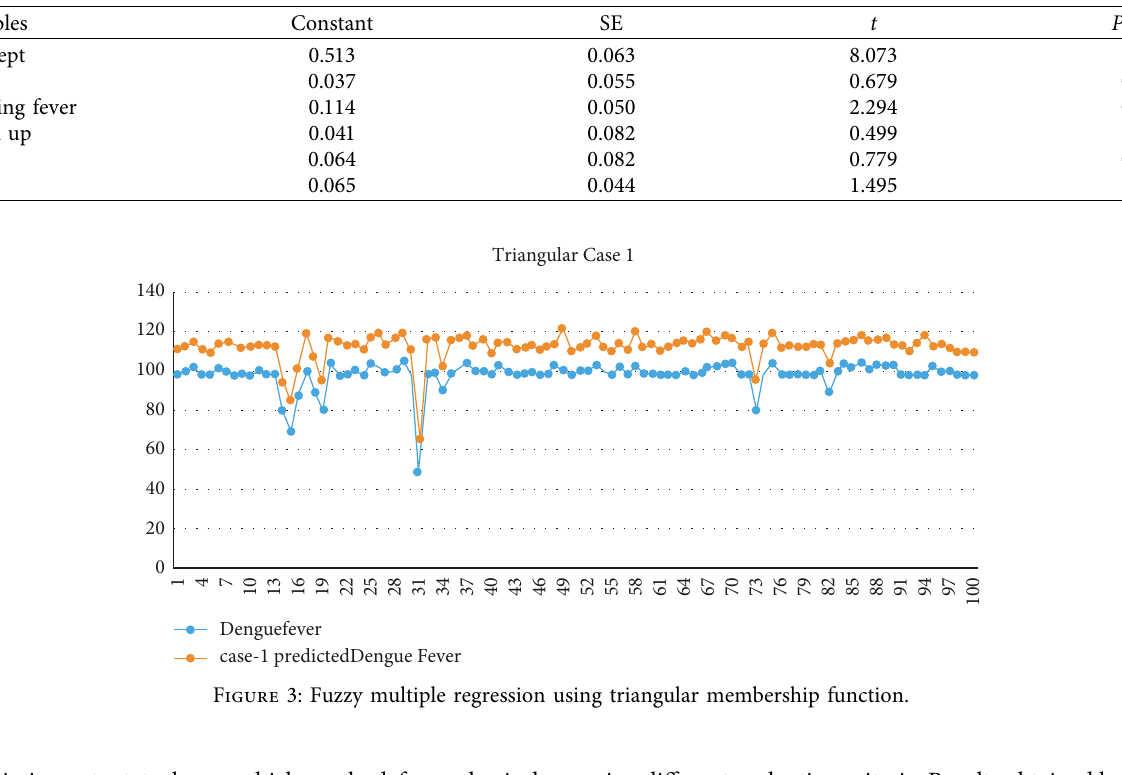
Table 4: Result of fuzzy multiple regression when fuzzy independent variables and crisp-dependent variable in triangular membership function.